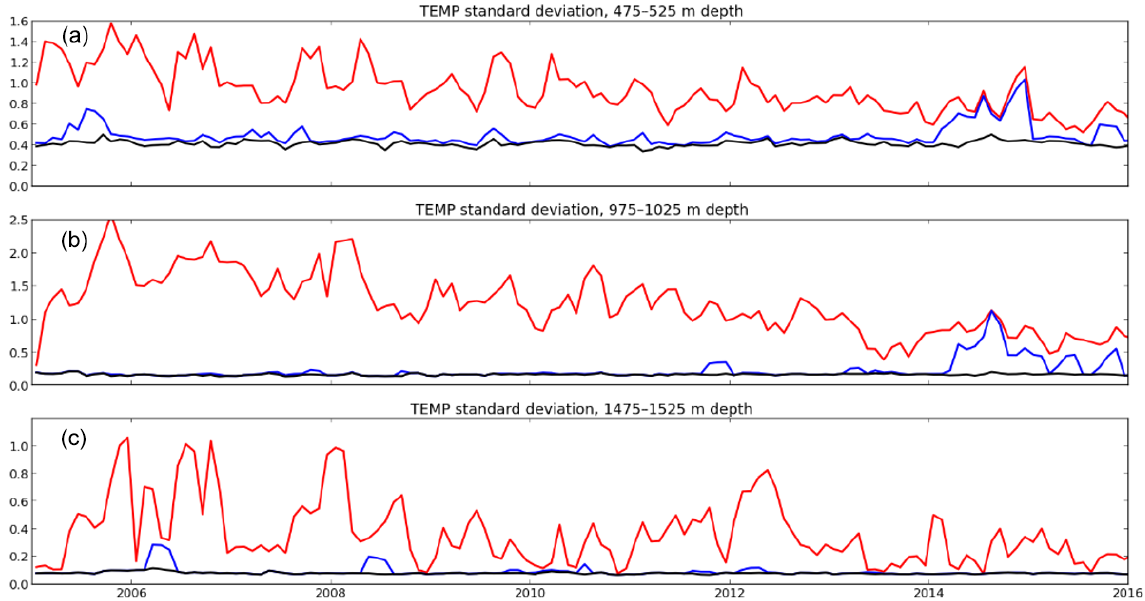
Figure 10. Mean temperature standard deviation in the 475–525m depth layer (a) , 975–1025m depth layer (b) , and 1475–1525m depth layer (c) . The raw dataset (red), NRT dataset (blue), and CORA dataset (black) are